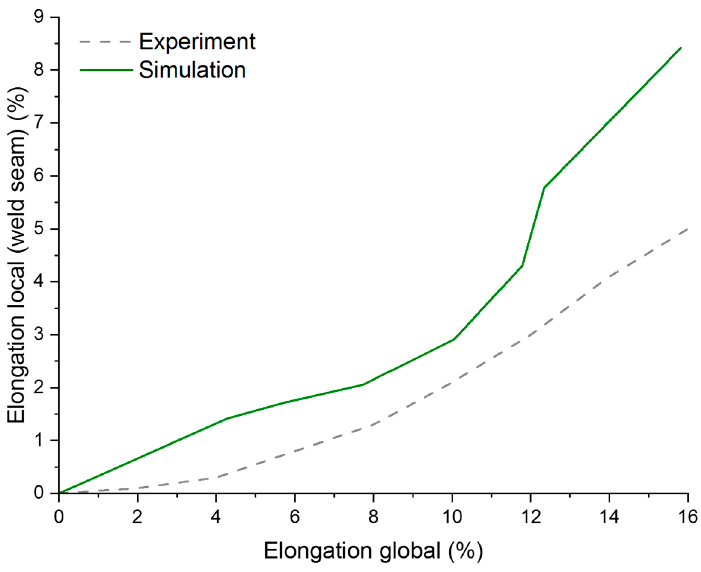
Figure 16. Comparison of sensor strain values obtained from numerical simulation and experiments.